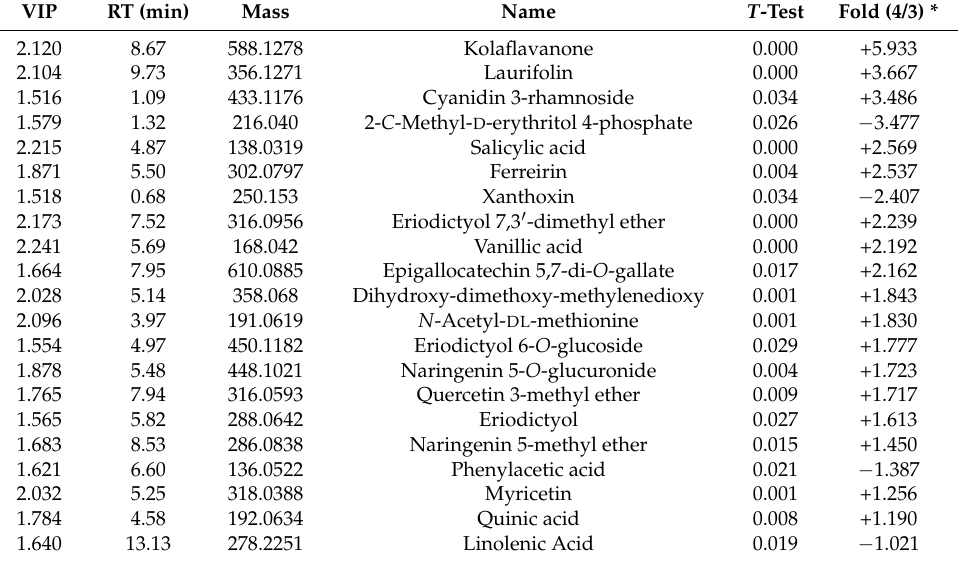
Table 6. The main identification obtained between 3 days and 4 days in ESI − ( p < 0.05).